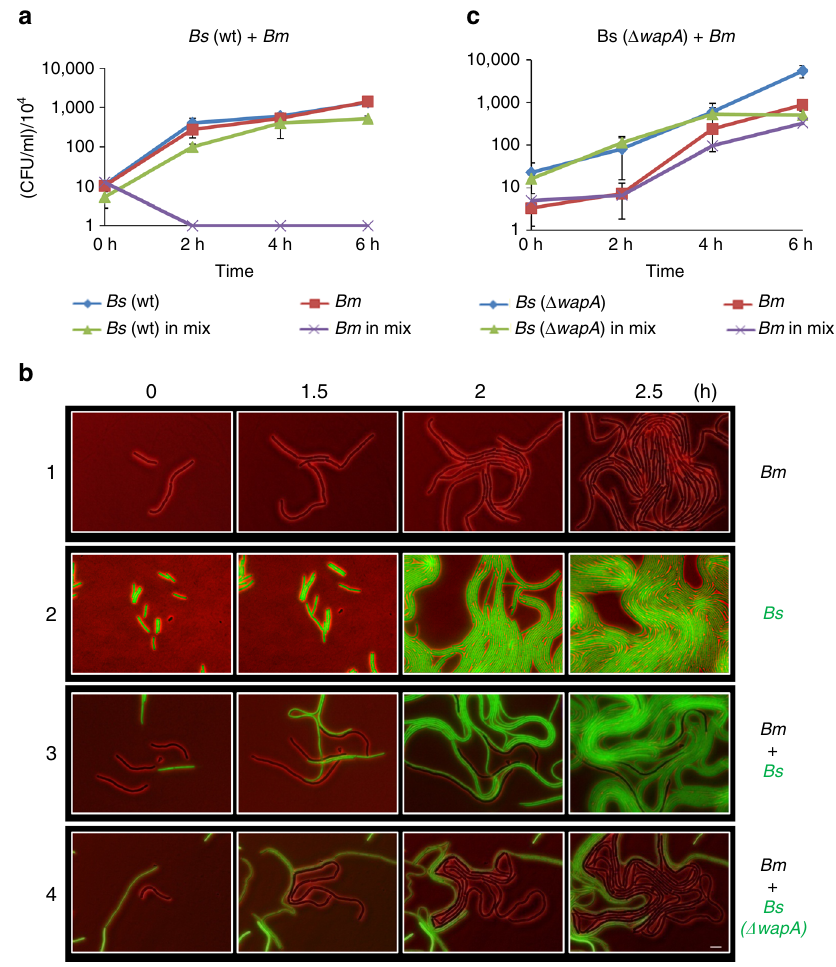
Fig. 1 Bm inhibition by Bs is mediated by the WapA toxin. a Bs (PY79, wt) and Bm (OS2) were grown separately or in a mixture in LB medium at 37 °C. Cells were plated for CFUs at the indicated time points. Each point represents an average value and s.d. of three independent experiments. b Representative time lapse microscopy images of (1) Bm (OS2), (2) Bs (AR16: amyE:: P rrnE -gfp ), (3) a mixture of Bm (OS2) and Bs (AR16), and (4) a mixture of Bm (OS2) and Bs (OS24: Δ wapA, sacA:: P veg-mCherry ). Shown are overlay fl uorescence from GFP or mCherry ( green ) and phase contrast ( red ) images, captured at the indicated time points. Bm cells are shown in black while Bs cells are shown in green . Scale bar represents 5 µ m. c Bs (OS16:: Δ wapA ) and Bm (OS2) were grown separately or in a mixture and processed as in a . Each point represents an average value and s.d. of three independent